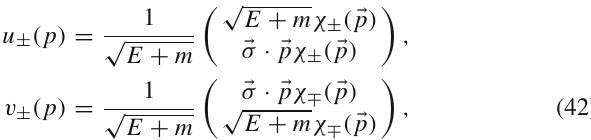
with and with- D ( D ∗ )